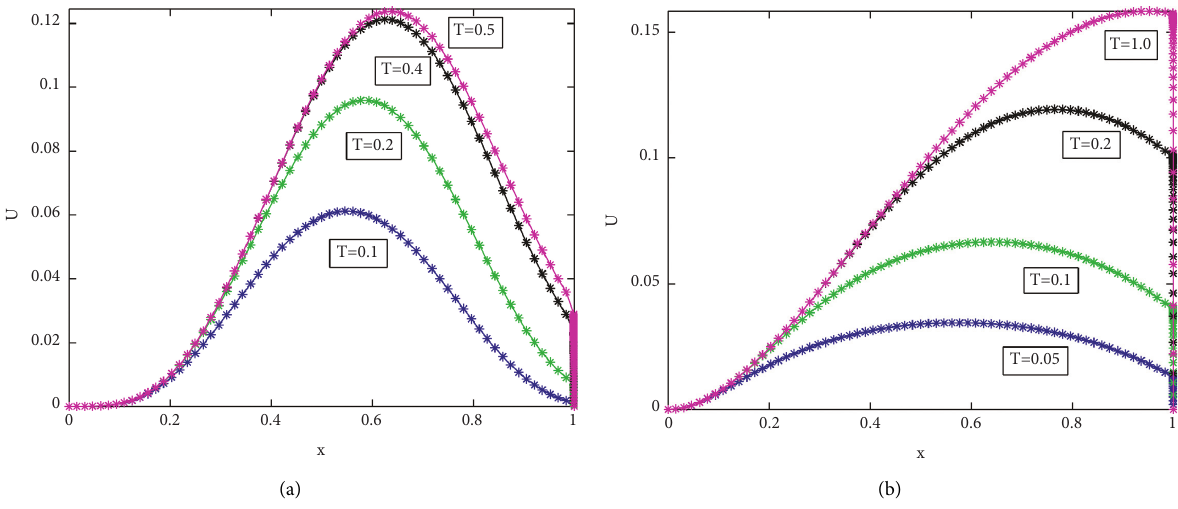
Figure 1: Solution profile for different time level on (a) Example 1 and (b) Example 2 for ε � 2 − 5 .